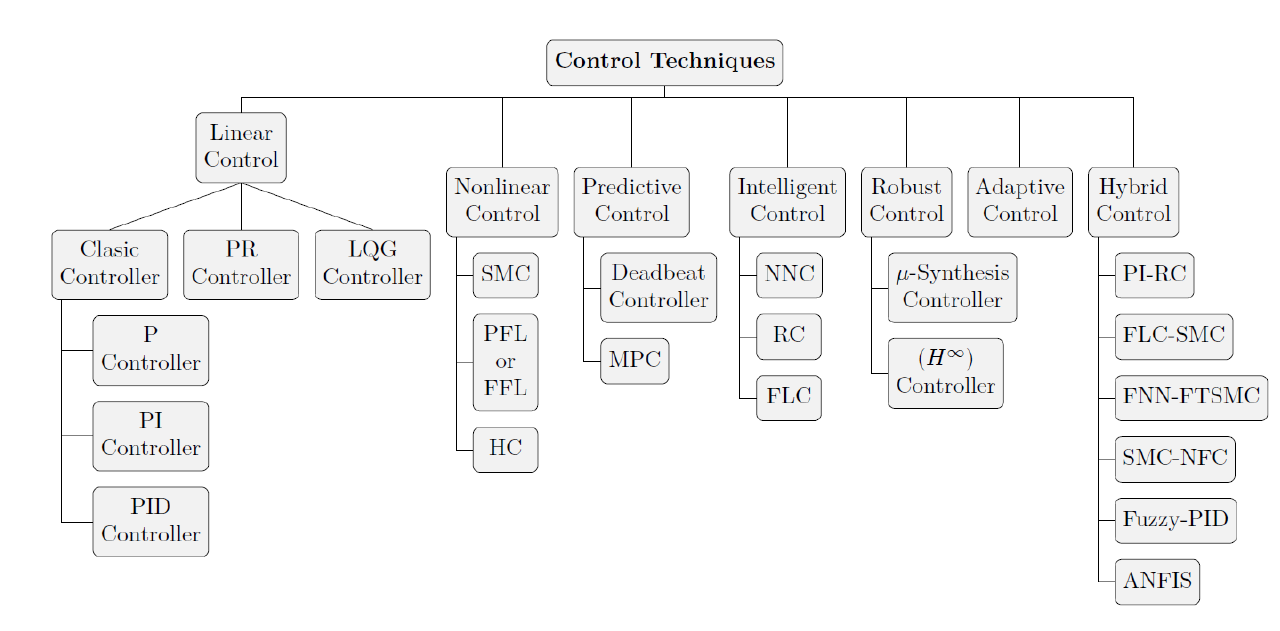
Figure 20. Classification of Control